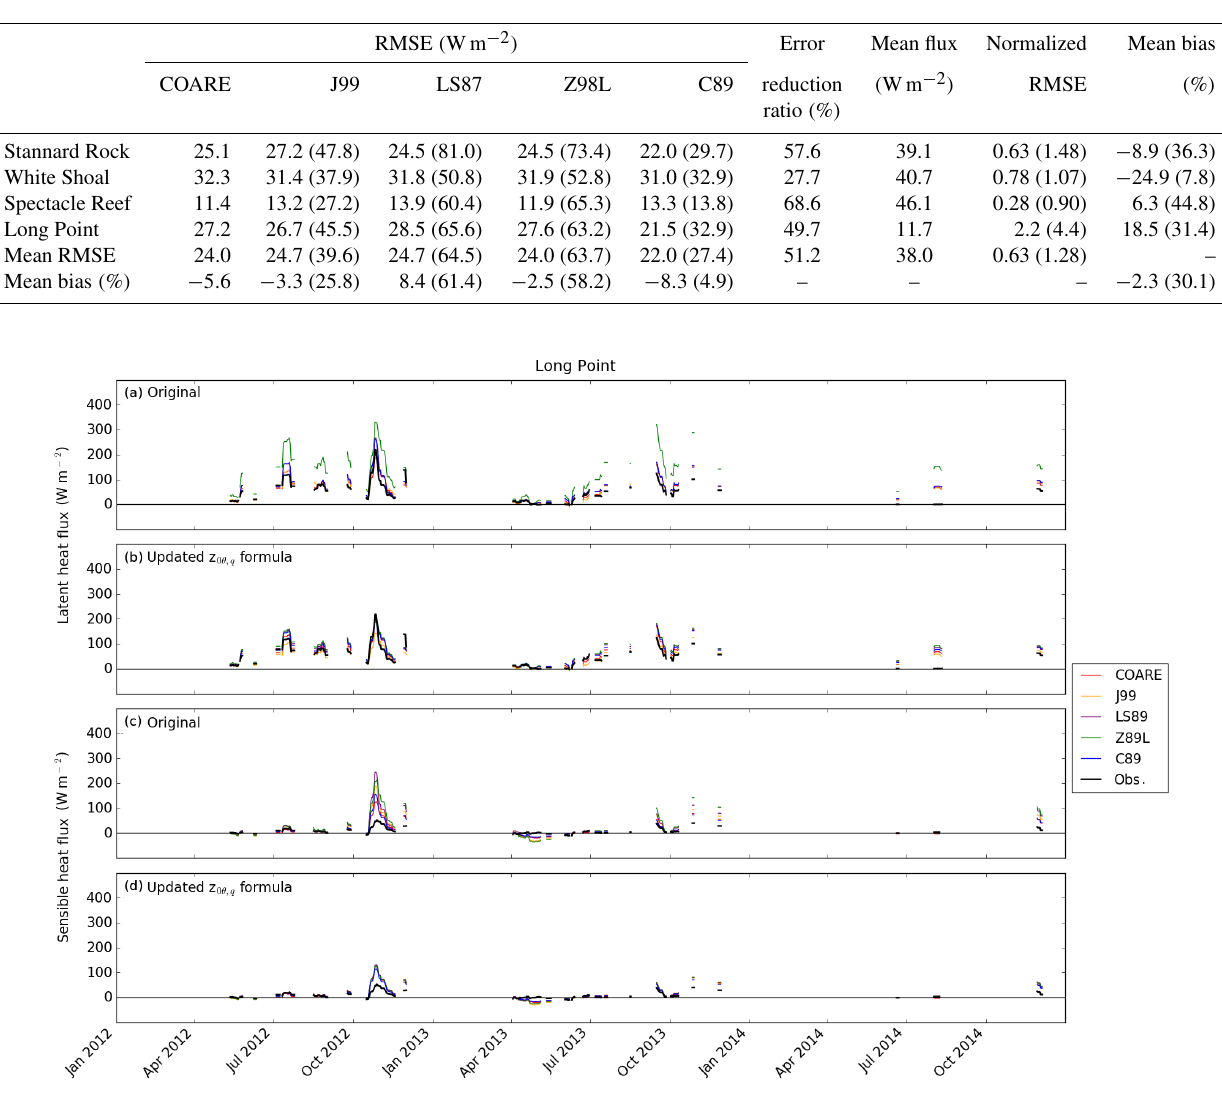
Table 3. Same as Table 2, but for sensible heat flux H .